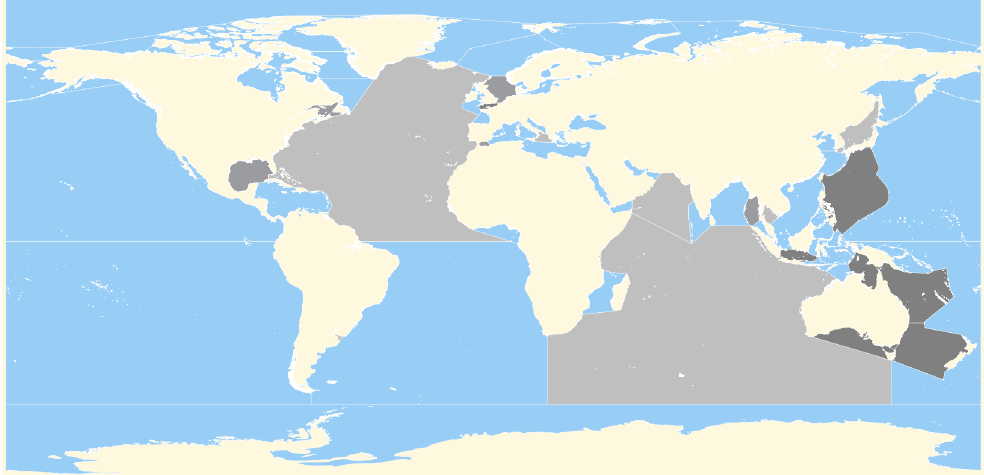
Figure 11. The IHO seas regions of the world. The regions are gray when the percentage column of | U | > 2 kn is greater than 2.47% and it gets darker when it dev